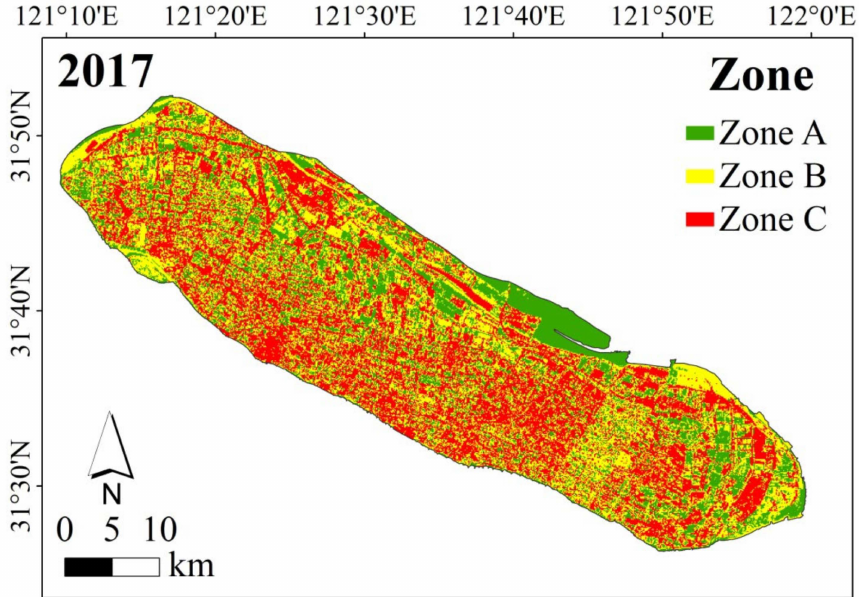
Figure 13. Different functional zones based on the SIEHI-1 and SIEHI-2: Zone A is mainly for protection function; Zone B is for the harmonious coexistence of protection and development; and Zone C is mainly for development